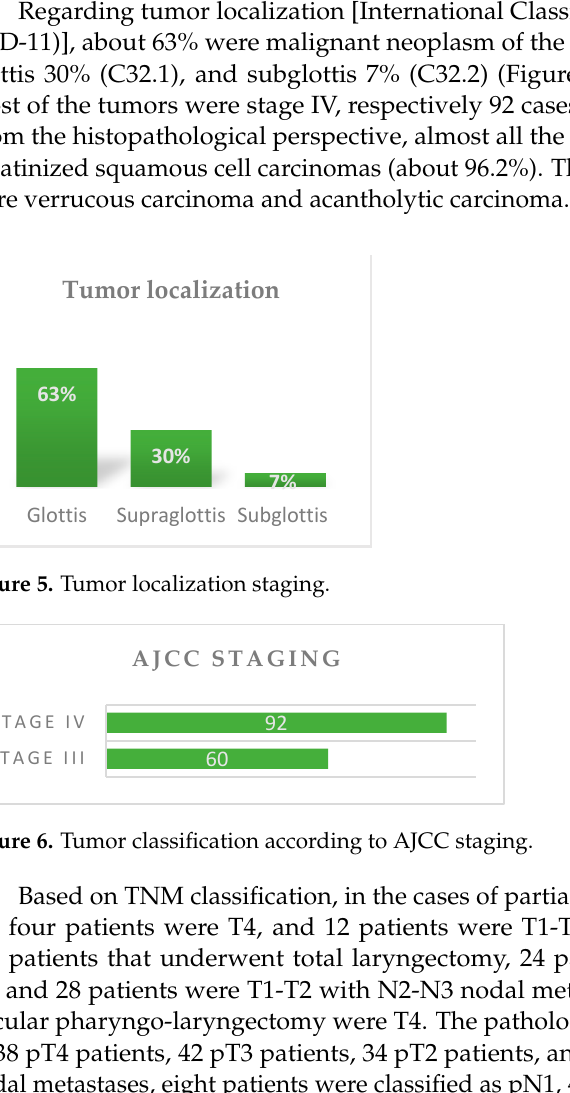
Figure 4. Symptoms associated with laryngeal cancer.